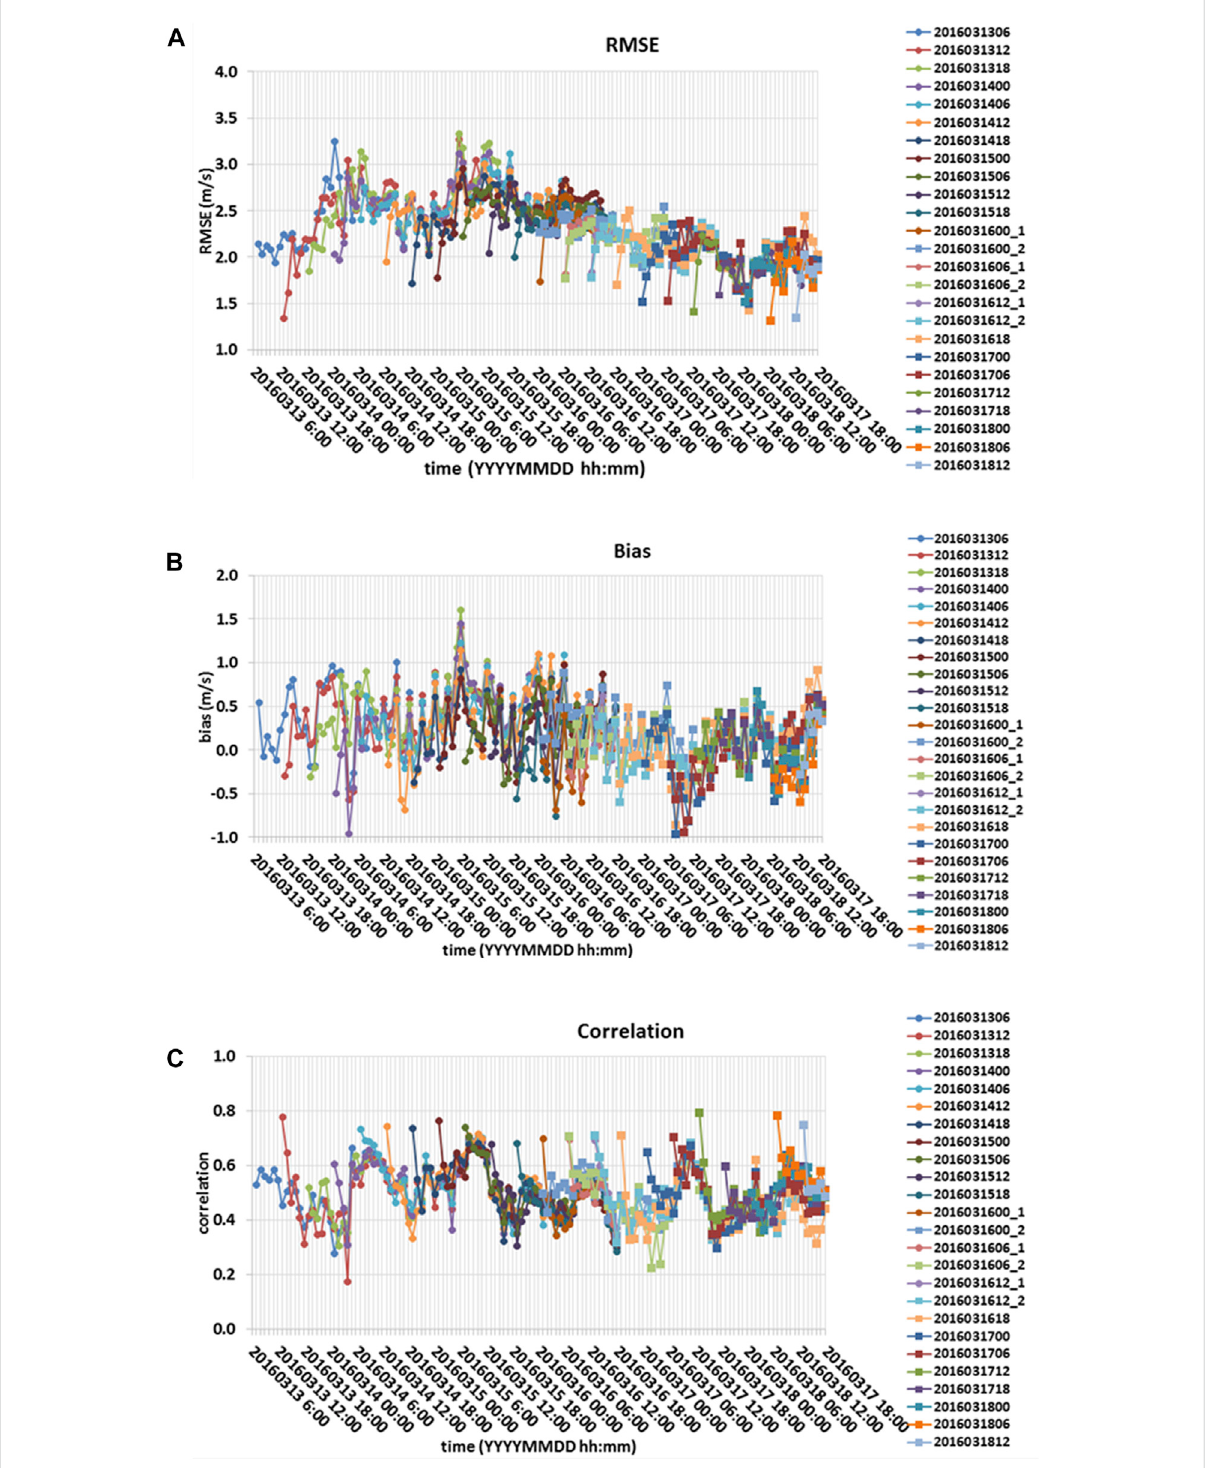
FIGURE 2 (A) RMSE, (B) Bias, and (C) Correlation of 10-m wind speed (m/s) calculated over all the stations. Filled circles and fi lled squares represent free forecast cycles following the fi rst and second cold starts, respectively. The X axis lists the dates and hours of the start of the free forecast cycles. Different colors represent different free forecasts